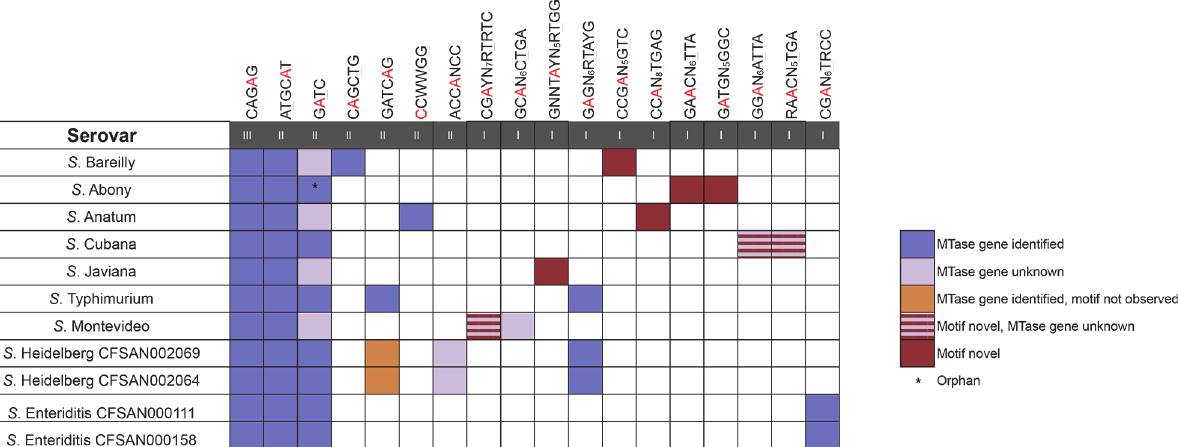
Fig 1. The methylomes of eleven Salmonella serovars. Violet = MTase identified, light violet = MTase unknown, red = novel motif, orange = MTase present in genome, motif not observed. Light violet/red stripe = novel motif, MTase unknown. Roman numerals indicate MTase type (I – III). Note the majority of novel MTases are Type I